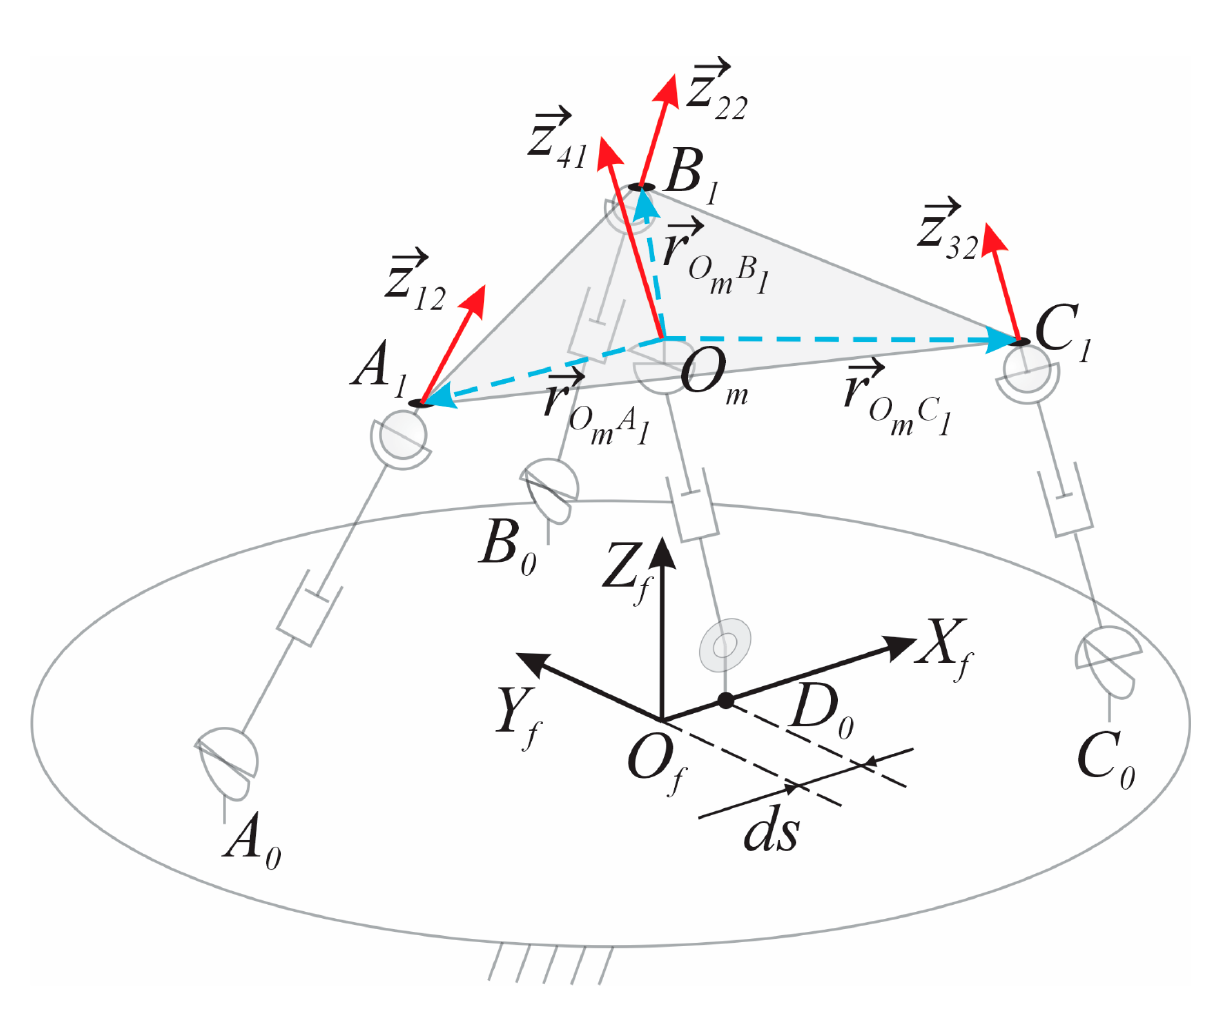
Figure 2. TWSs in the 3UPS+RPU